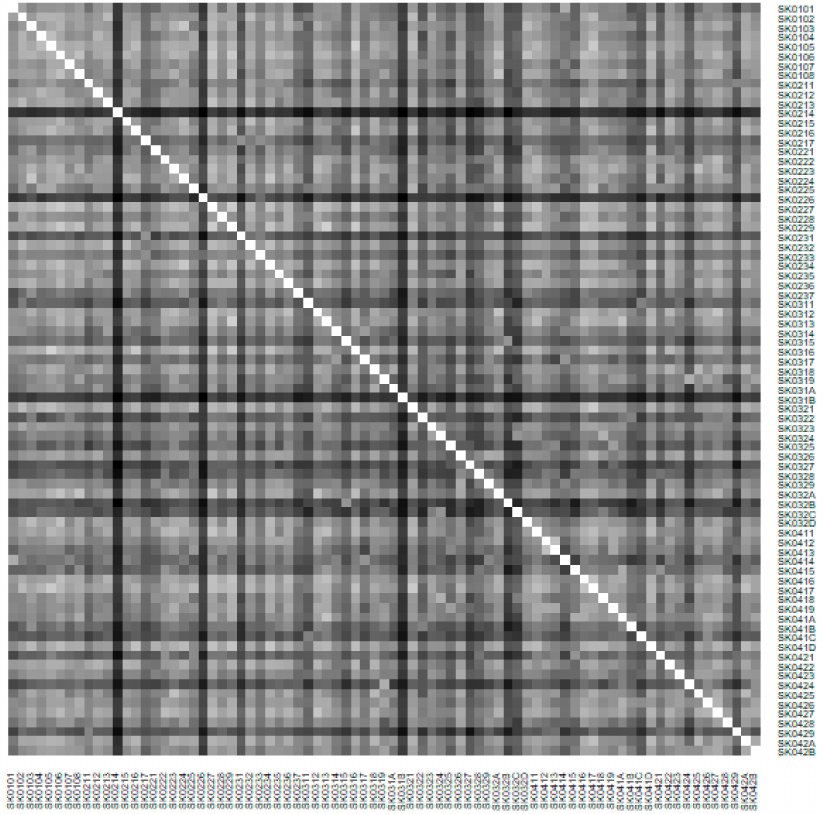
Figure 14. Preventable mortality heat map of the districts for the female sex in the year 2008. Source: own elaboration by the